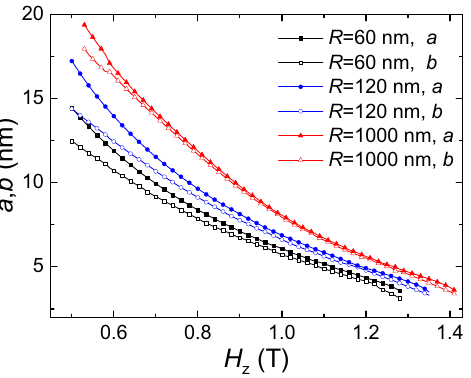
Figure 10. The size of skyrmion as a function of the magnetic field H z in curved films with different R